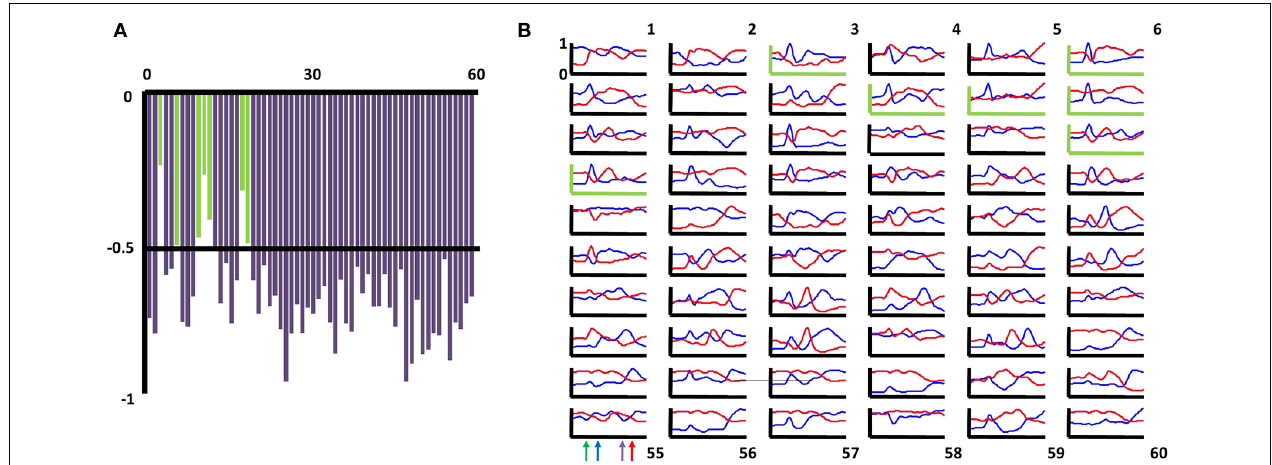
FIGURE 4 | Basal forebrain categories of task-phase-specific firing have counterparts with negatively correlated patterns. (A) For each of the 60 categories of task-phase-specific basal forebrain (BF) firing patterns, the correlation of the mean firing pattern for that group’s members (neurons) and all other groups was determined. Shown are the maximally negative correlations obtained for each group. 53 of the 60 groups (88%) had counterparts for which the mean firing pattern among its members bore a correlation more negative than ( − 0.5). Those yielding weaker correlations